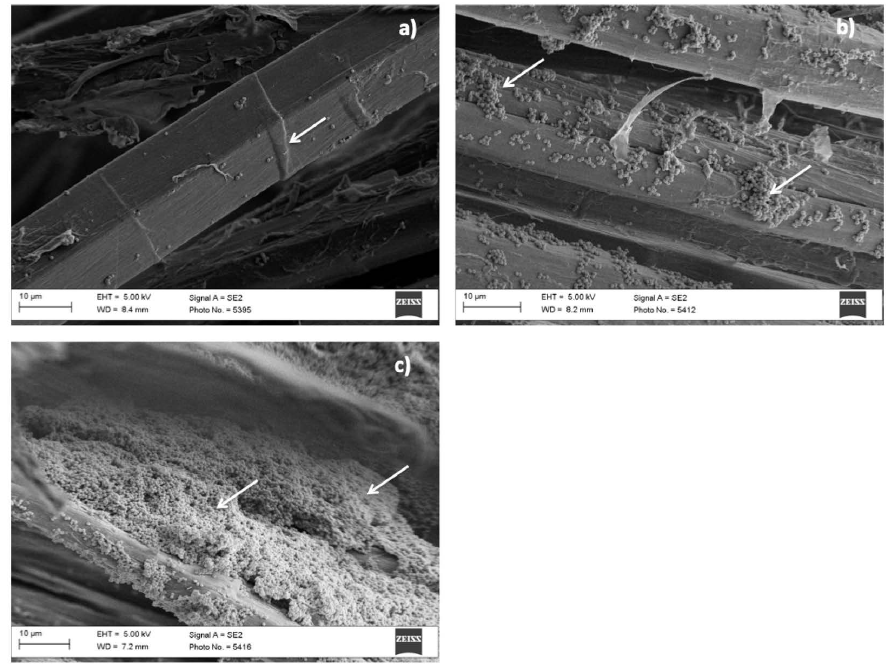
Figure 2. SEM pictures reporting di ff erent stages of bacterial adhesion and biofilm formation on flax fibers. Single cells of S. aureus adhered onto the substrate ( a ); initial steps of biofilm formation locally aggregated onto the surface of the fiber ( b ); dense structured biofilm completely covering the flax substrate ( c